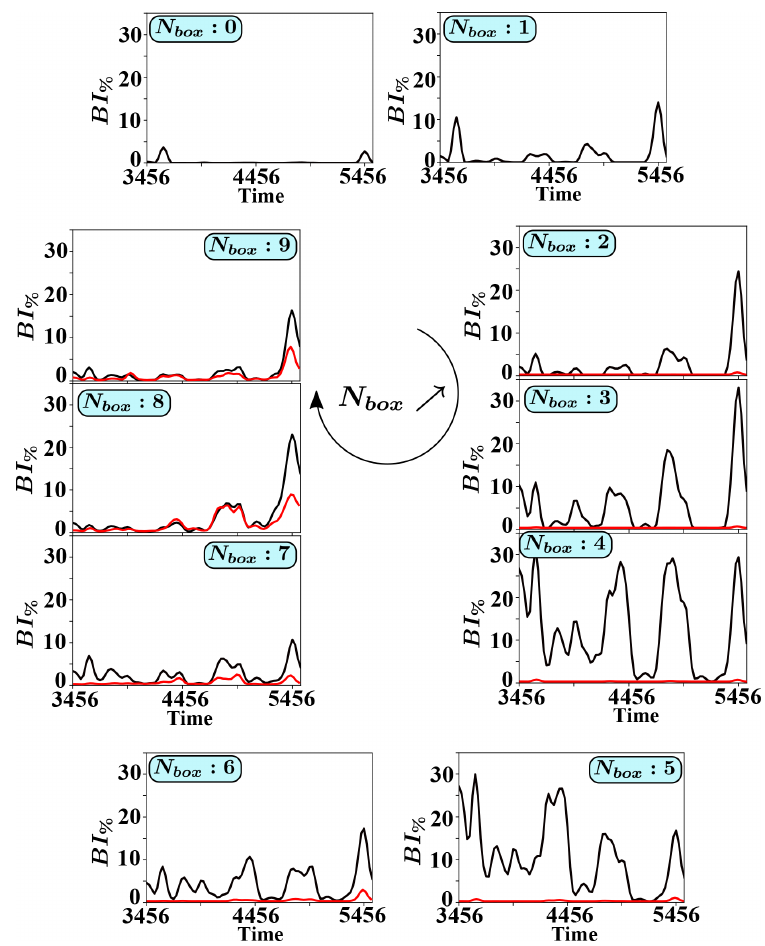
Figure 9. HE configuration: percentage BI % of back-streaming ions measured at the end of each simulation, where each time corresponds to a given fixed shock front. For each shock profile in homothetic expansion, the simulation covers 3 (cid:101) τ ci , allowing one to obtain a well- developed ion foreshock, and BI % represents the ratio of the back-streaming ions over the total number of upstream ions which are released at the beginning of the simulation within a given box. As in Fig. 7, black and red lines correspond to the case when the E l field is included and artificially excluded, respectively. The concerned shock profiles are chosen only at late times of the full PIC simulation (from (cid:101) T = 3456 to 5474), where the curvature radius of the shock front is relatively large ( (cid:101) R > 70 (cid:101) ρ ci